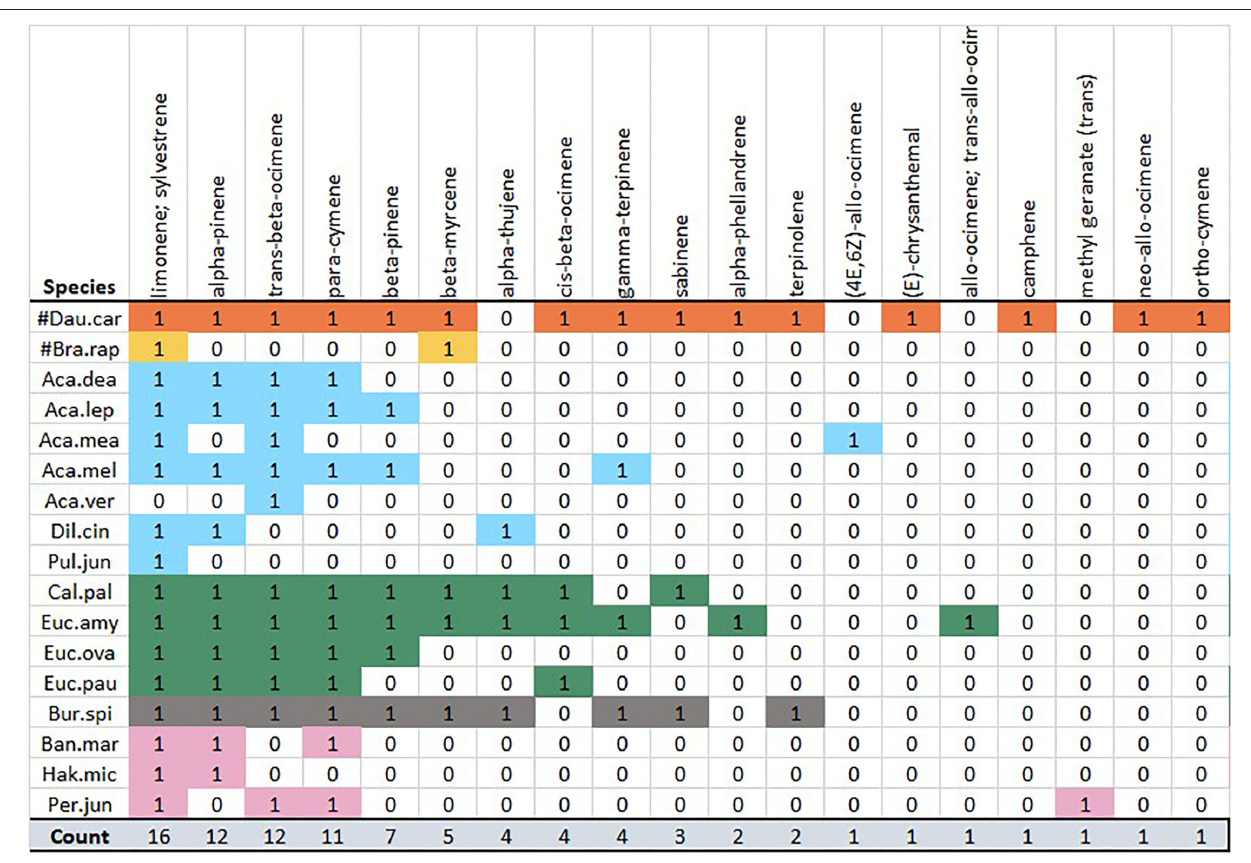
FIGURE 4 | Complete method matrix: monoterpene subsection. Monoterpene presence–absence is shown against study species. Species grouped and colored by genera, presence of a volatile = 1, absence = 0. Volatiles ordered from most to least